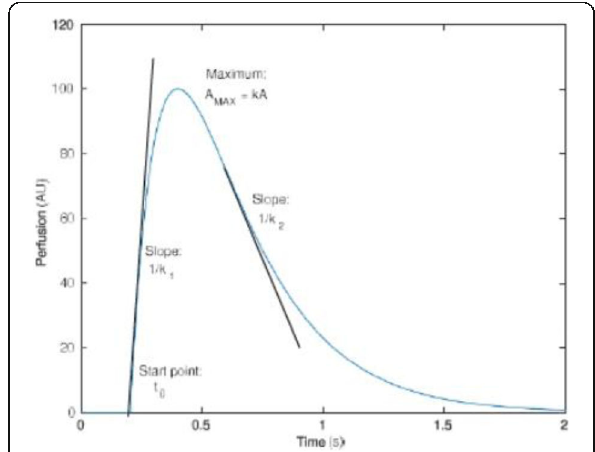
Fig. 1 (abstract A150). Exponential pulse with graphic representation of the parameters.